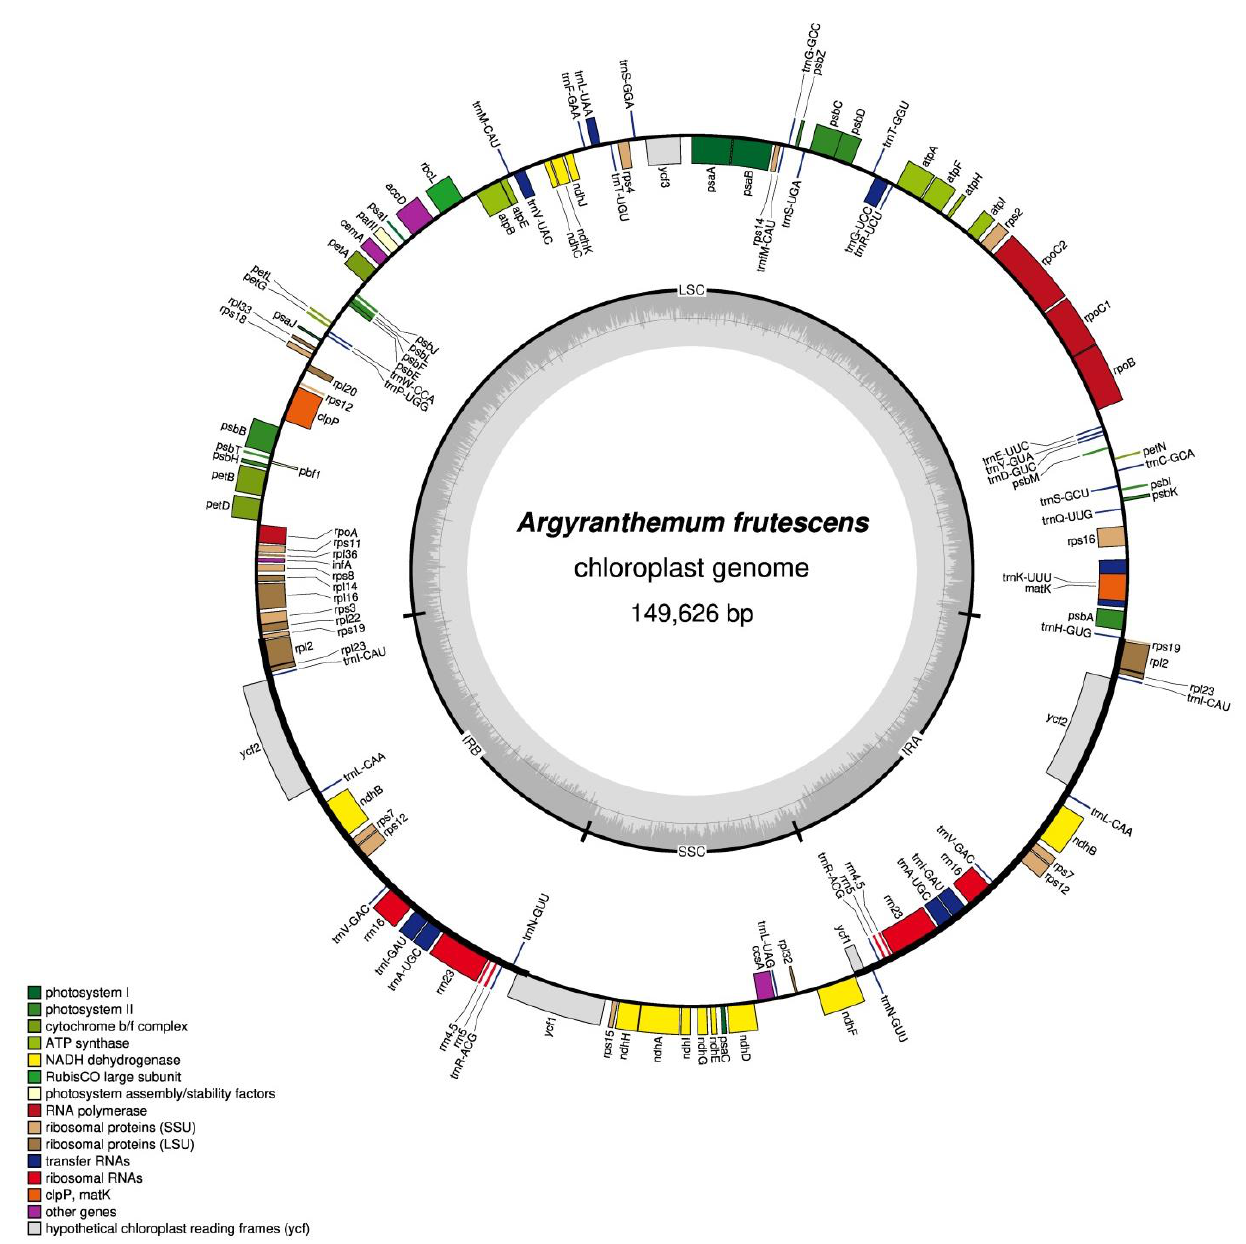
Figure 1. Circular chloroplast genome of the A. frutescens . Genes presented inside the circle were transcribed counter-clockwise, and those drawn outside were transcribed clockwise. Color-coding represents different gene functional groups .